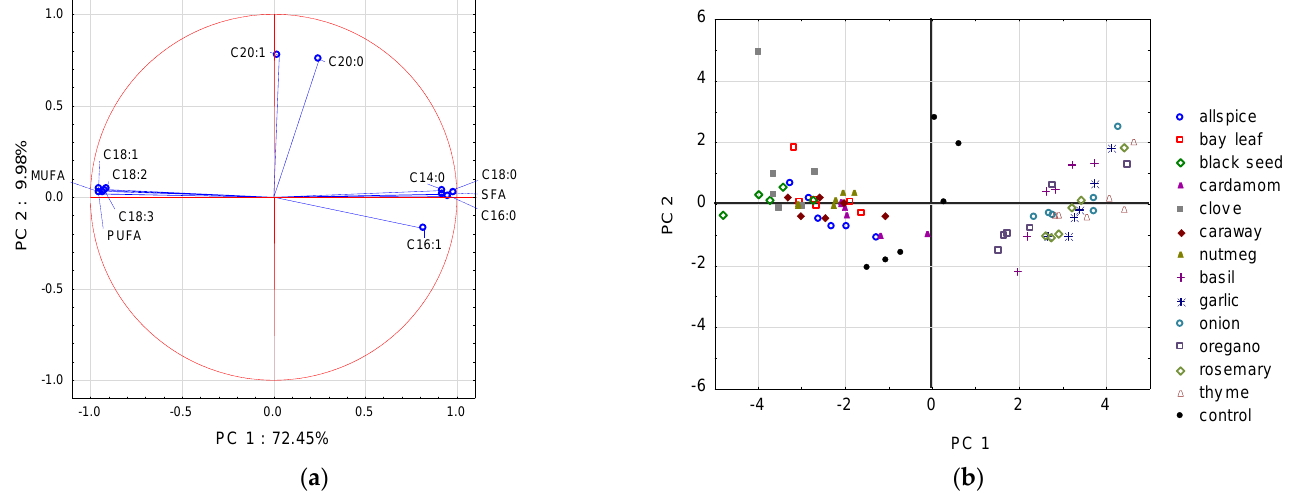
Figure 3. Projections of the ( a ) variables (fatty acids) and ( b ) scores (plant extracts) for raw beef meat samples onto the factor plane defined by principal components (PC1 and PC2).